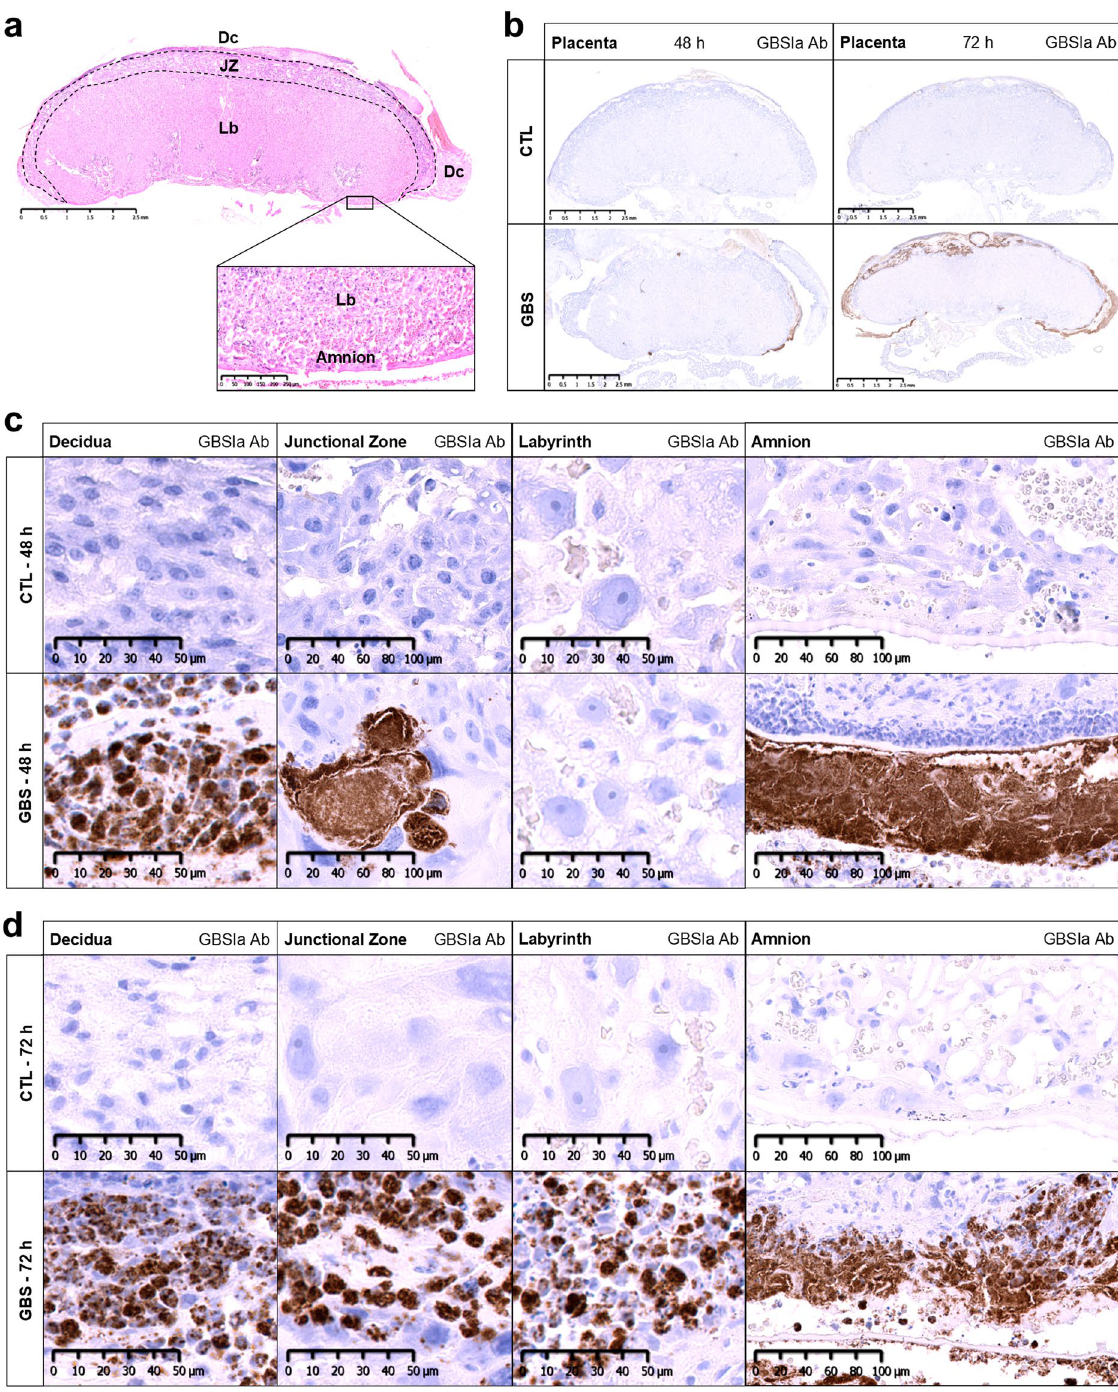
Figure 1. Placental group B Streptococcus (GBS) infection. ( a ) Global anatomical aspect of coronal section of the placenta stained by hematoxylin and eosin presenting the maternal (decidua [Dc]), maternofetal (junctional zone [JZ]) and fetal (labyrinth [Lb]) compartments, as well as the amnion. ( b ) Representative images of immunohistochemical detection of GBS serotype Ia showing placentas of dams exposed or unexposed (CTL) to GBS. Scale bar, 2.5 mm. ( c , d ) Representative GBS-stained bacteria infiltrates in the decidua, junctional zone, labyrinth and amnion at 48 h ( c ) and 72 h ( d ) post-inoculation by GBS. Abbreviations: Ab, Antibody; CTL, Control; Dc, Decidua; GBS, Group B Streptococcus ; h, hour; JZ, Junctional Zone; Lb,